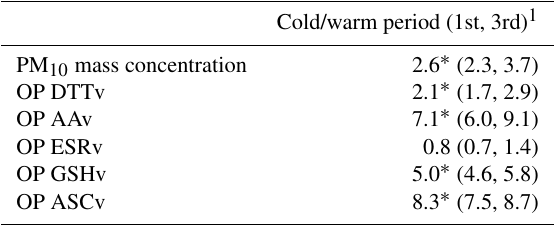
Table 1. Median ratios between cold (late November to late Febru- ary) and warm (late May to late September) periods for PM 10 mass concentration and OP measurements expressed per m 3 (OPv).